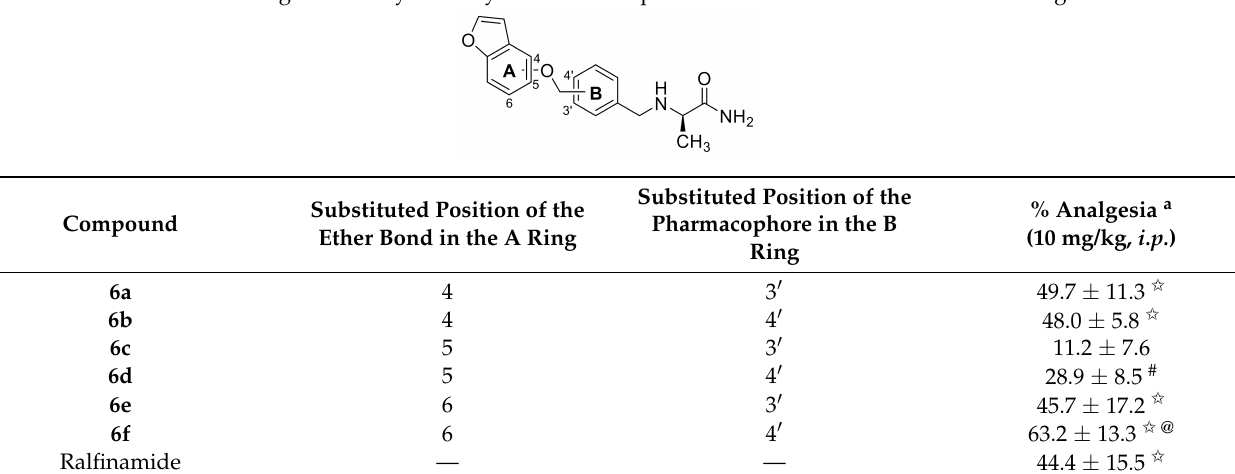
Table 2. The analgesic activity of the synthesized compounds in the acetic acid-induced writhing test.